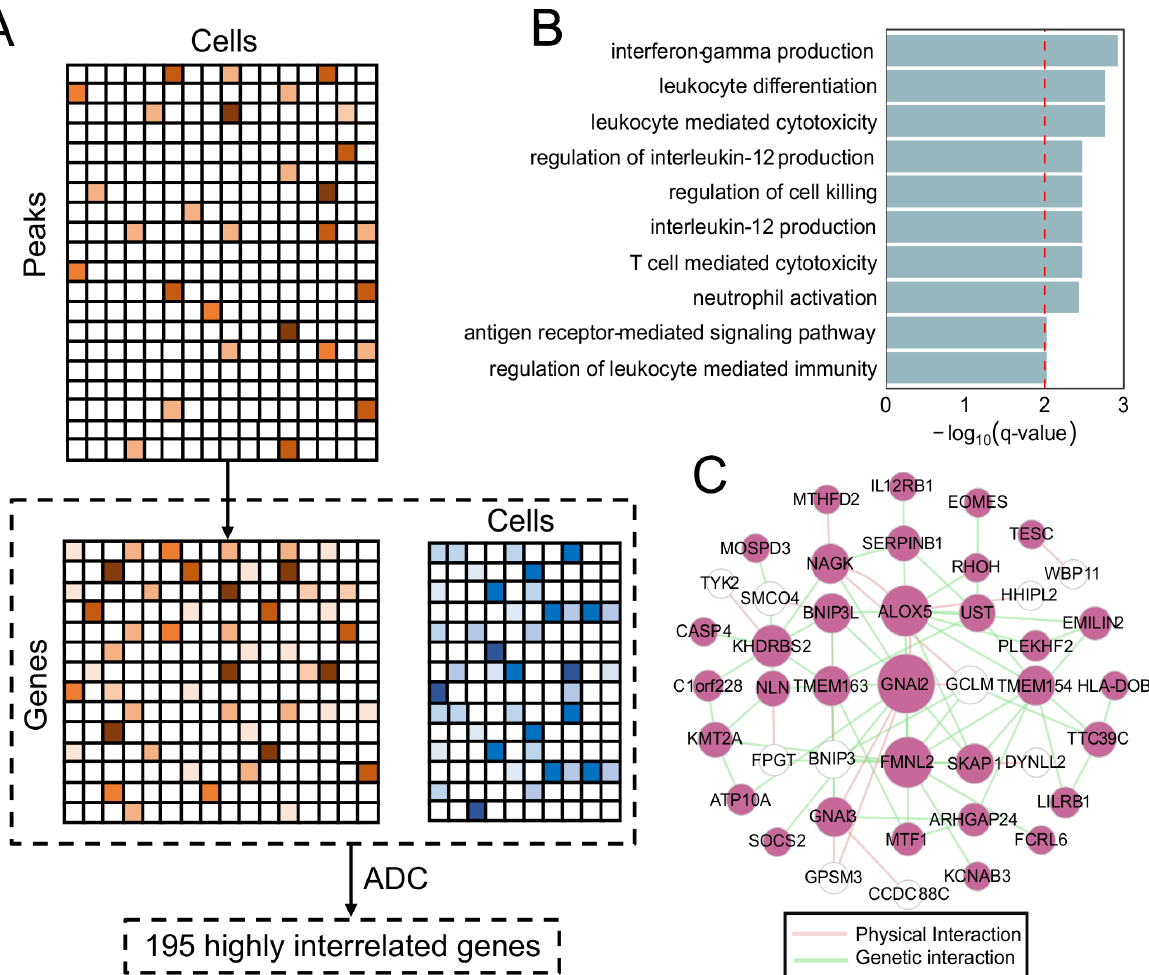
Fig 7. Biological functions and network analysis of highly interrelated genes selected by ADC across modalities. (A) Schematic diagram shows the work flow of performing ADC on the scRNA-seq data and scATAC-seq data (FDR = 0.20). We first converted the scATAC-seq data to a predicted gene expression matrix. Specifically, we constructed a “gene activity matrix” from scATAC-seq dataset by utilizing the reads at gene body and 2kb upstream, then ADC was applied to a pseudo gene expression data and a real one. (B) The top enriched functional terms of the genes selected by ADC. (C) The gene network constructed with GeneMANIA using the top genes selected by ADC.